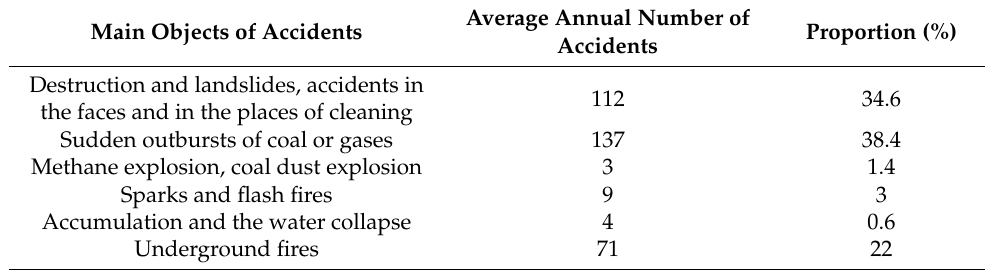
Table 2. Classification by types of accidents at coal enterprises in Russia. Average Annual Number Main Objects of Accidents